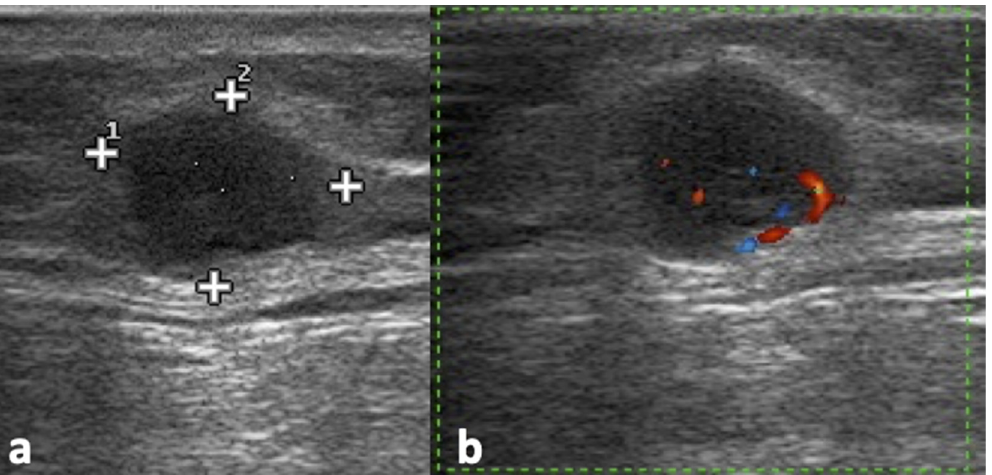
Figure 2. Left subscapular lymphadenopathy representing the recurrence of a cutaneous melanoma on the trunk. The B-Mode US scan ( a ) shows an oval, markedly hypoechoic, inhomogeneous lymph node with irregular borders. The color Doppler scan ( b ) shows prevalent peripheral flow signals.